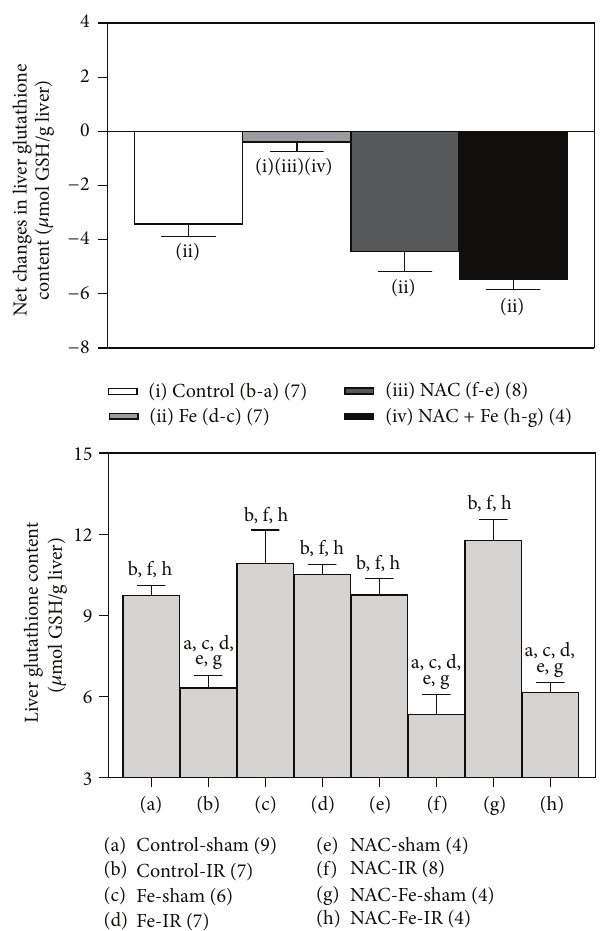
Figure 4: Effects of N-acetylcysteine (NAC) and/or iron (Fe) short-term administration on liver reduced glutathione (GSH) content in rats subjected to ischemia-reperfusion (IR). Animals were treated as shown in Figure 1. Data are expressed as means ± SEM for 4 to 9 animals per group. Significance studies ( 𝑃 < 0.05 ; one-way ANOVA and Newman-Keuls’ test) are indicated by the letters identifying each experimental group. Inset: net changes in liver GSH levels induced by IR correspond to the differences between groups (b-a) (controls), (d-c) (Fe), (f-e) (NAC), and (h-g) (NAC +